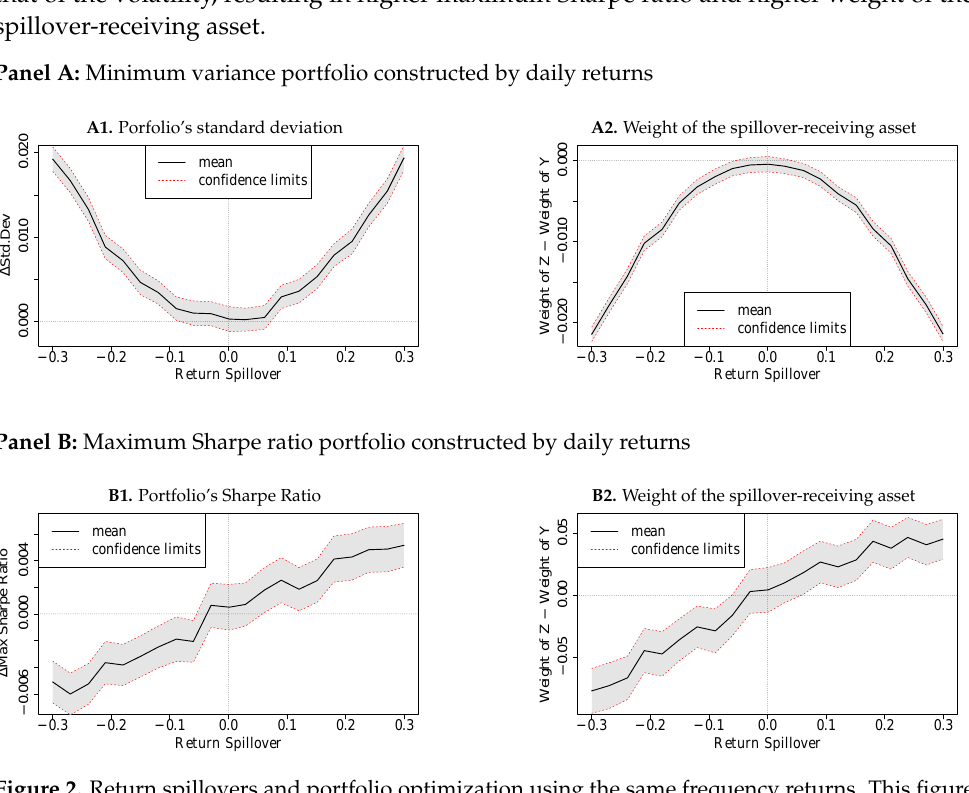
Figure 2. Return spillovers and portfolio optimization using the same frequency returns. This figure presents the differences in characteristics of optimal portfolios formed by daily returns with and without daily return spillover. We use “daily” for the illustration purpose; the results apply to any other frequency. Panel A presents the differences in standard deviation and in the weight of the spillover-receiving asset in the minimum variance portfolio. Panel B presents the differences in the Sharpe ratio and in the weight of the spillover-receiving asset in the portfolio targeting maximum Sharpe ratio. Shaded areas represent 1% confidence intervals. For brevity, we only report graphs with a = 0. The graphs with a = − 0.5 and a = 0.5 are qualitatively